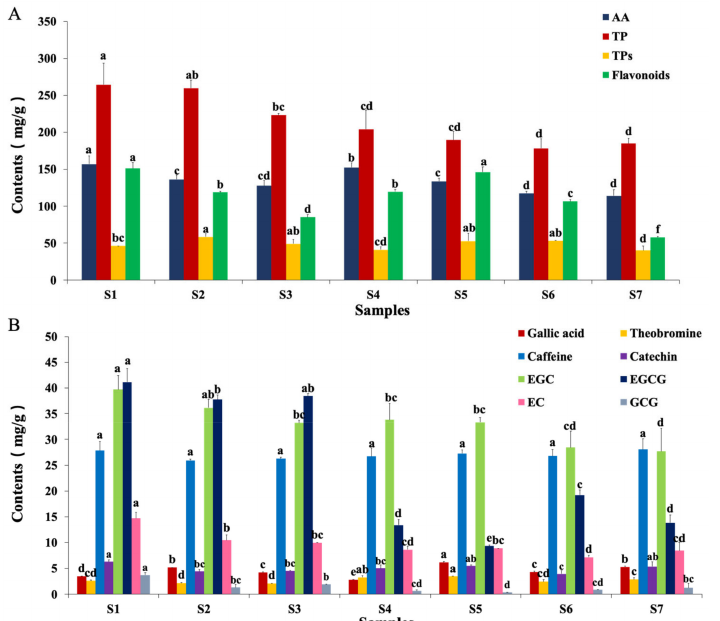
Figure 6. Biochemical measurements of functional components of Fu brick tea. ( A ) Changes of total flavonoids, tea polyphenols (TP), tea polysaccharide (TPs) and free amino acid (AA). ( B ) The contents of Gallic acid, theobromine, caffeine, catechin, catechin, epigallocatechin (EGC), epigallocatechin gallate (EGCG), epicatechin (EC) and galloca-techin gallate (GCG) were determined during processing and storage in Fu brick tea; the data in three replicas, (a–f) expressed p <